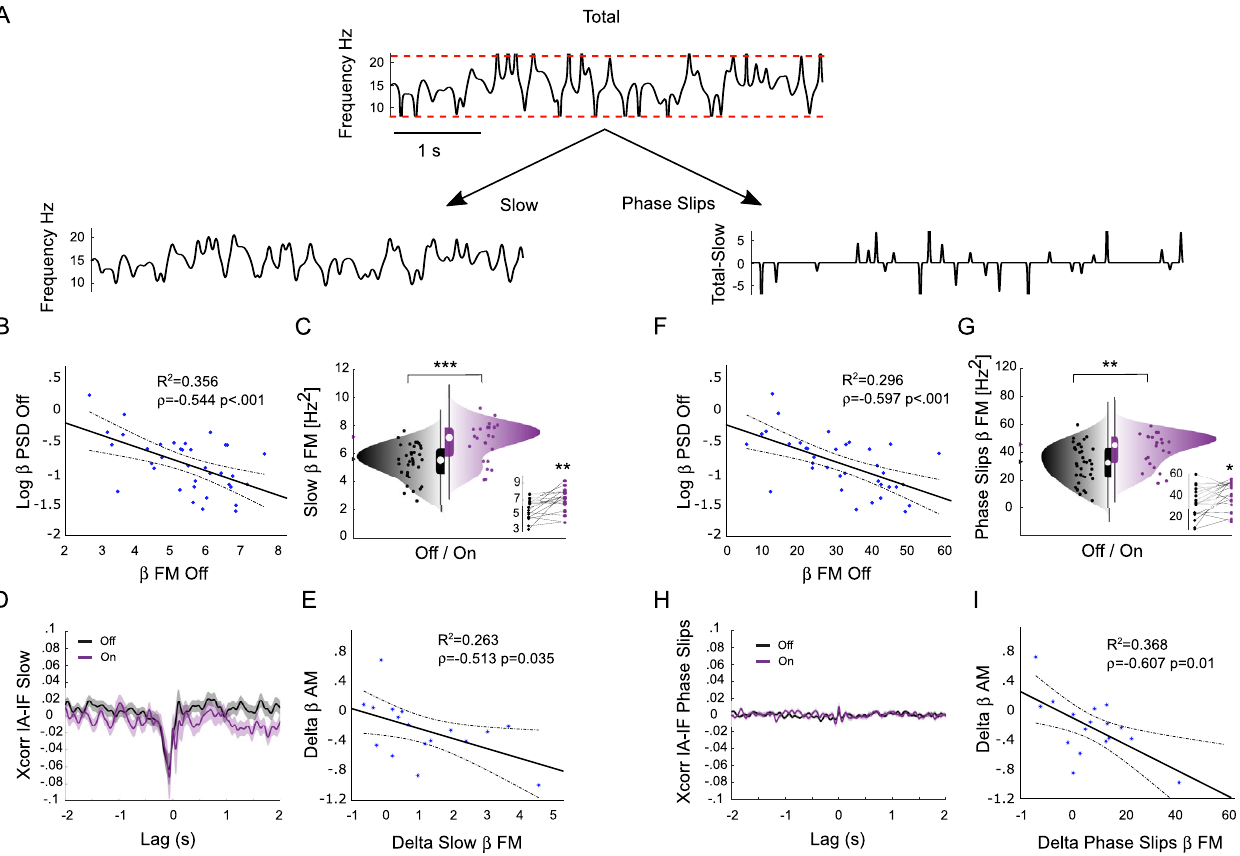
Fig. 3 Evaluation of slow and phase-slips components of FM. A Representative instantaneous frequency signal before (Total) and after (Slow, left) phase slips removal, and corresponding phase-slips signal (right). Red dotted lines represent frequency limits of the band-pass fi lter that was used in the phase estimation procedure. B , F Scatter plots of β PSD vs. ( B ) slow FM or ( F ) phase-slips FM in nuclei recorded OFF medication. C , G Raincloud plots of ( C ) slow FM or ( G ) phase-slips FM, OFF (black) and ON (violet) levodopa. Insets show FM changes for the subset of subjects that were recorded in both the experimental conditions. D , H Cross-correlation function (Xcorr) between instantaneous amplitude (IA) and ( D ) slow or ( H ) phase-slips instantaneous frequency (IF) OFF (black) and ON (violet) levodopa. E , I Scatter plots of dopamine-dependent changes in AM (delta AM) and ( E ) slow FM or ( I ) phase-slips FM (delta FM). Thick and dotted lines are the regression lines and corresponding 95% con fi dence limits, respectively. ** p < 0.01, *** p < 0.001. In the boxplots, the central white circle indicates the median and the box limits indicate the 25th and 75th percentiles. Whiskers at ±1.5 interquartile range. Slow FM and phase-slips FM differently contributed to the dopamine-dependent changes in FM and in the AM-FM